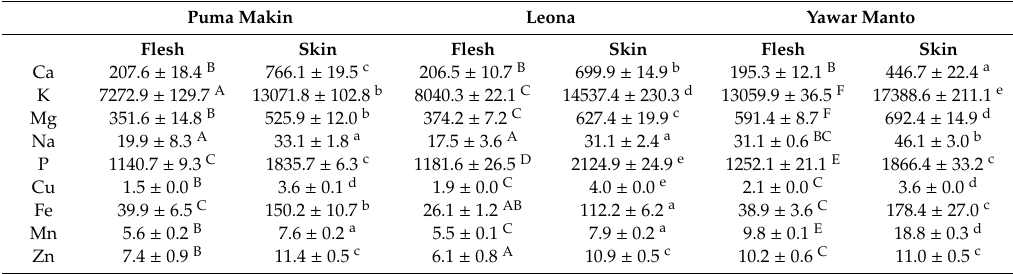
Table 3. Mineral content in the tubers expressed as µ g / g dry weight (DW). Data are expressed as mean ± standard deviation. Di ff erent letters indicate significant di ff erences among varieties, for each compound ( p < 0.05) for the flesh tissue (uppercase letters) and for the skin tissue (lowercase letters). Puma Makin Leona Yawar Manto